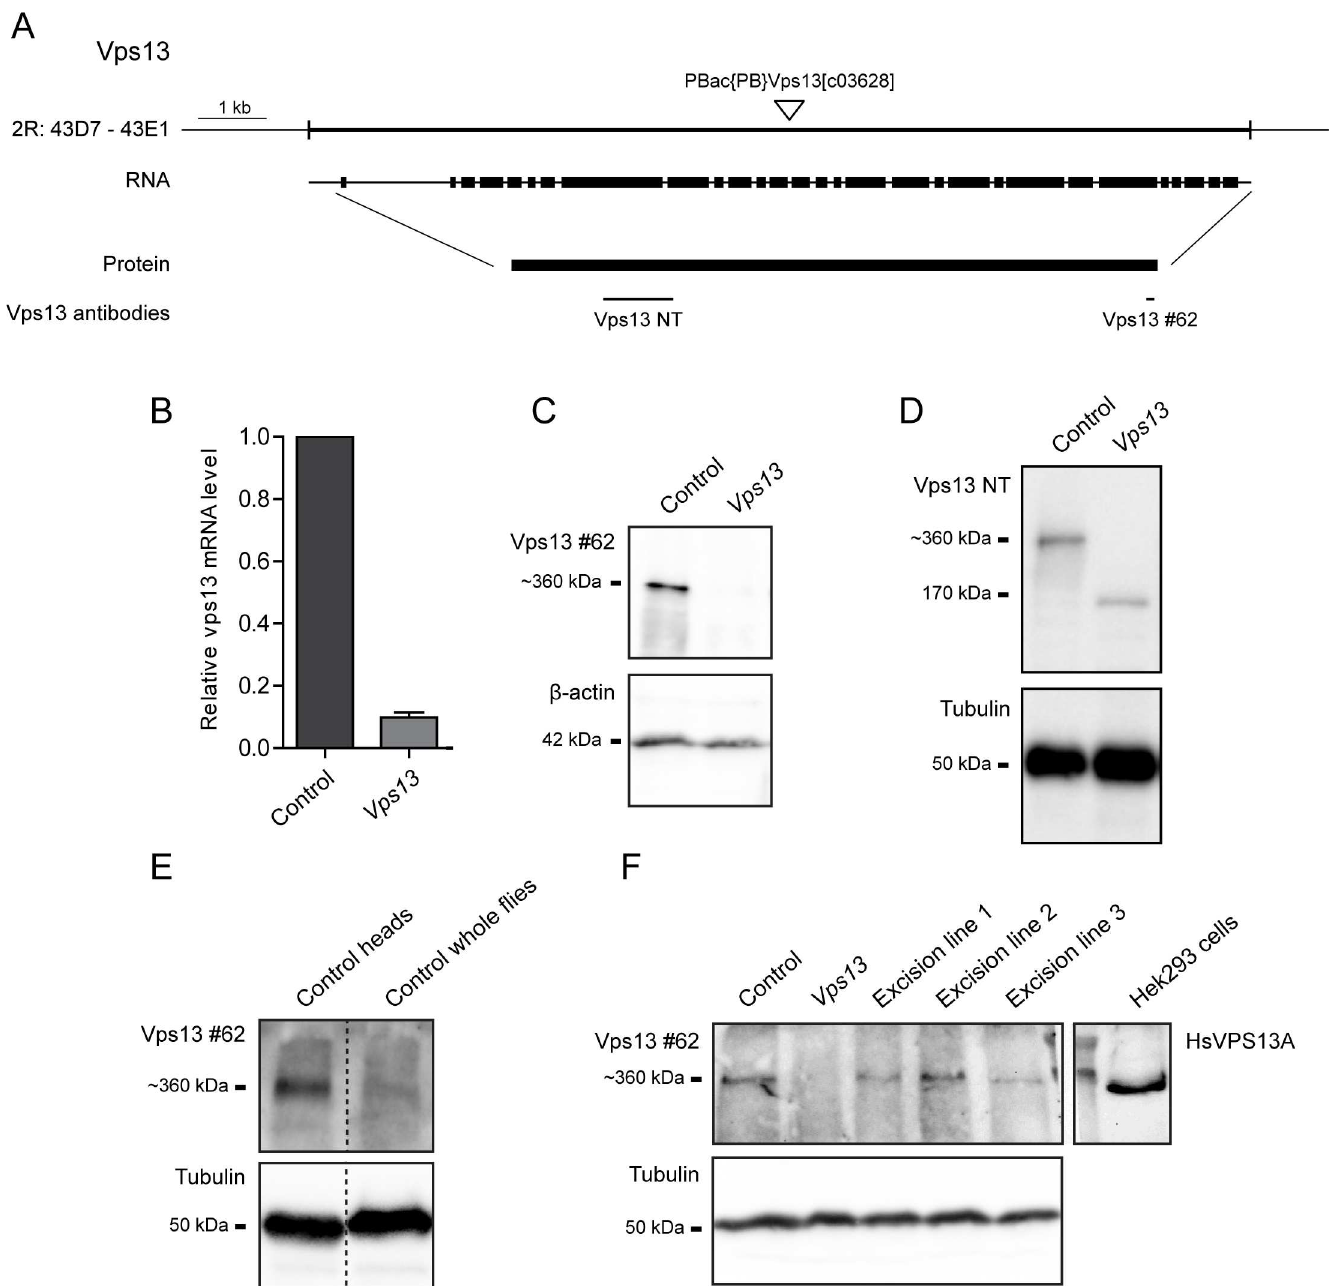
Fig 1. Vps13 c03628 encodes for a truncated Vps13 protein. (A) Schematic representation of the Vps13 gene and the genomiclocalization, RNA and protein is depicted. The epitopes of the polyclonalVps13 antibodies(Vps13 NT and Vps13 #62) are indicated.(B)Relativelevels of Vps13 mRNA in control and Vps13 mutant flies were determined by Q-PCR. Mean and SEM (n = 2) are plotted. (C) Western blot analysisof Vps13 protein in control and Vps13 mutant fly heads using the Vps13 #62 antibody. β -Actin was used as a loadingcontrol. (D) Western blot analysisof the level of Vps13 protein in control and Vps13 mutant fly head extracts analyzedwith the Vps13 NT antibody. α -tubulinwas used as a loadingcontrol. (E) Lysates of the heads of control flies and wholecontrol flies were analyzedfor Vps13 levels. α -tubulinwas used as a loadingcontrol. (F) Lysates of the headsof control flies, Vps13 mutant flies and three excisionlines were analyzedfor Vps13 levels. Human VPS13A was detected in samples of Hek293cells. Drosophila samples and humansamples were run on the same gel, separatedby a lane containingthe molecularweight standards, after transfer of the membrane, the marker lane was split to detect humanand Drosophila VPS13 separately using species specific antibodies. The marker lane was used to align the blots after antibodydetection. α - tubulin was used as a loadingcontrol.